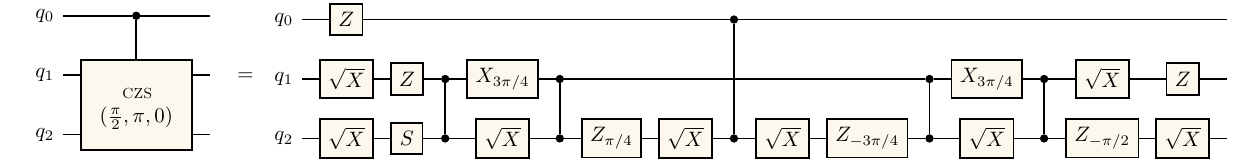
FIG. 8. Decomposition of the CCZS (π/ 2, π , 0 ) gate into single-qubit and CZ gates, obtained using Qiskit [154]. For the single-qubit √ √ gates, we use the notation S = Z = Z π/ 2 and X = X π/ 2 . Note that this decomposition requires qubit 2 being placed in the middle of the linear chain, since it has to perform CZ gates with both qubit 0 and qubit 1.